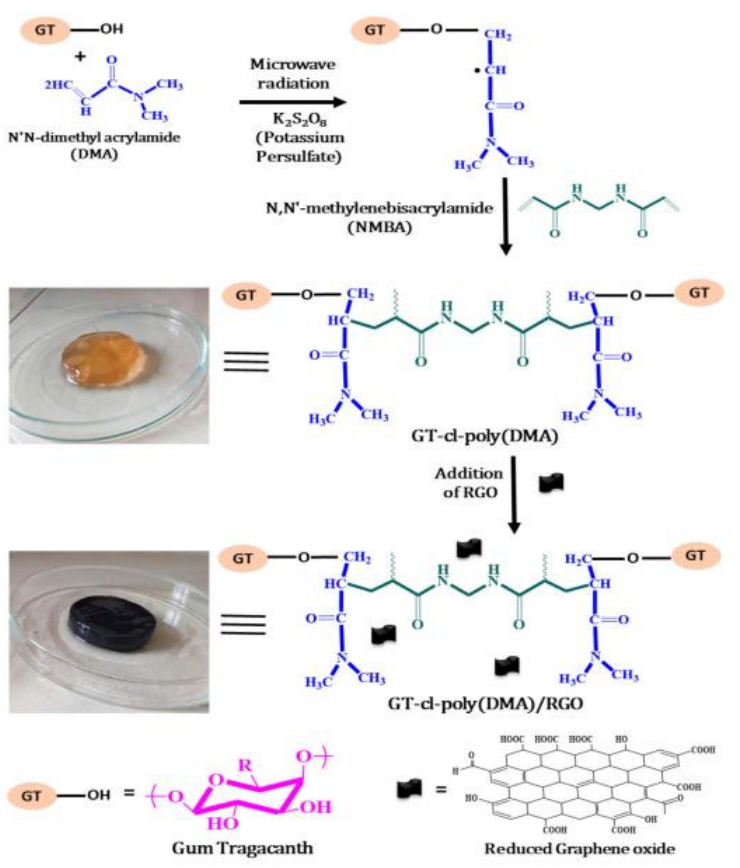
Figure 14. A scheme illustrated the preparation process of gum tragacanth-cl-N,N-dimethylacryla- mide/graphene hydrogel composite